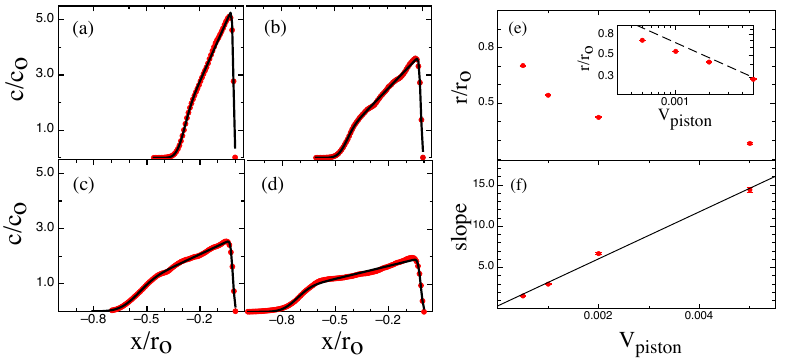
Figure 3. The steady state chain density c ( x , t ) along the channel axis for ( a ) a piston velocity V push = 0.05; ( b ) V push = 0.02; ( c ) V push = 0.01 and ( d ) V push = 0.005. (units of bond length per snapshot). The red lines are Brownian dynamics (BD) simulation output and the black lines represent the linear ramp steady-state profile predicted by the Nonlinear Partial Differential Equation (NPDE) model. Note that the linear ramp is convolved with a Gaussian function to represent the effect of thermal fluctuations that create an effective broadening of the profile shape. The extracted extension and ramp-slopes from the NPDE model fits ( a – d ) are shown in ( e , f ). The inset to ( e ) shows the same data on a log-log scale against a power law ∼ V − 0.5 (dashed-line). The bold line in ( f ) is a best linear fit push showing that the extracted slopes are linearly proportional to the pushing